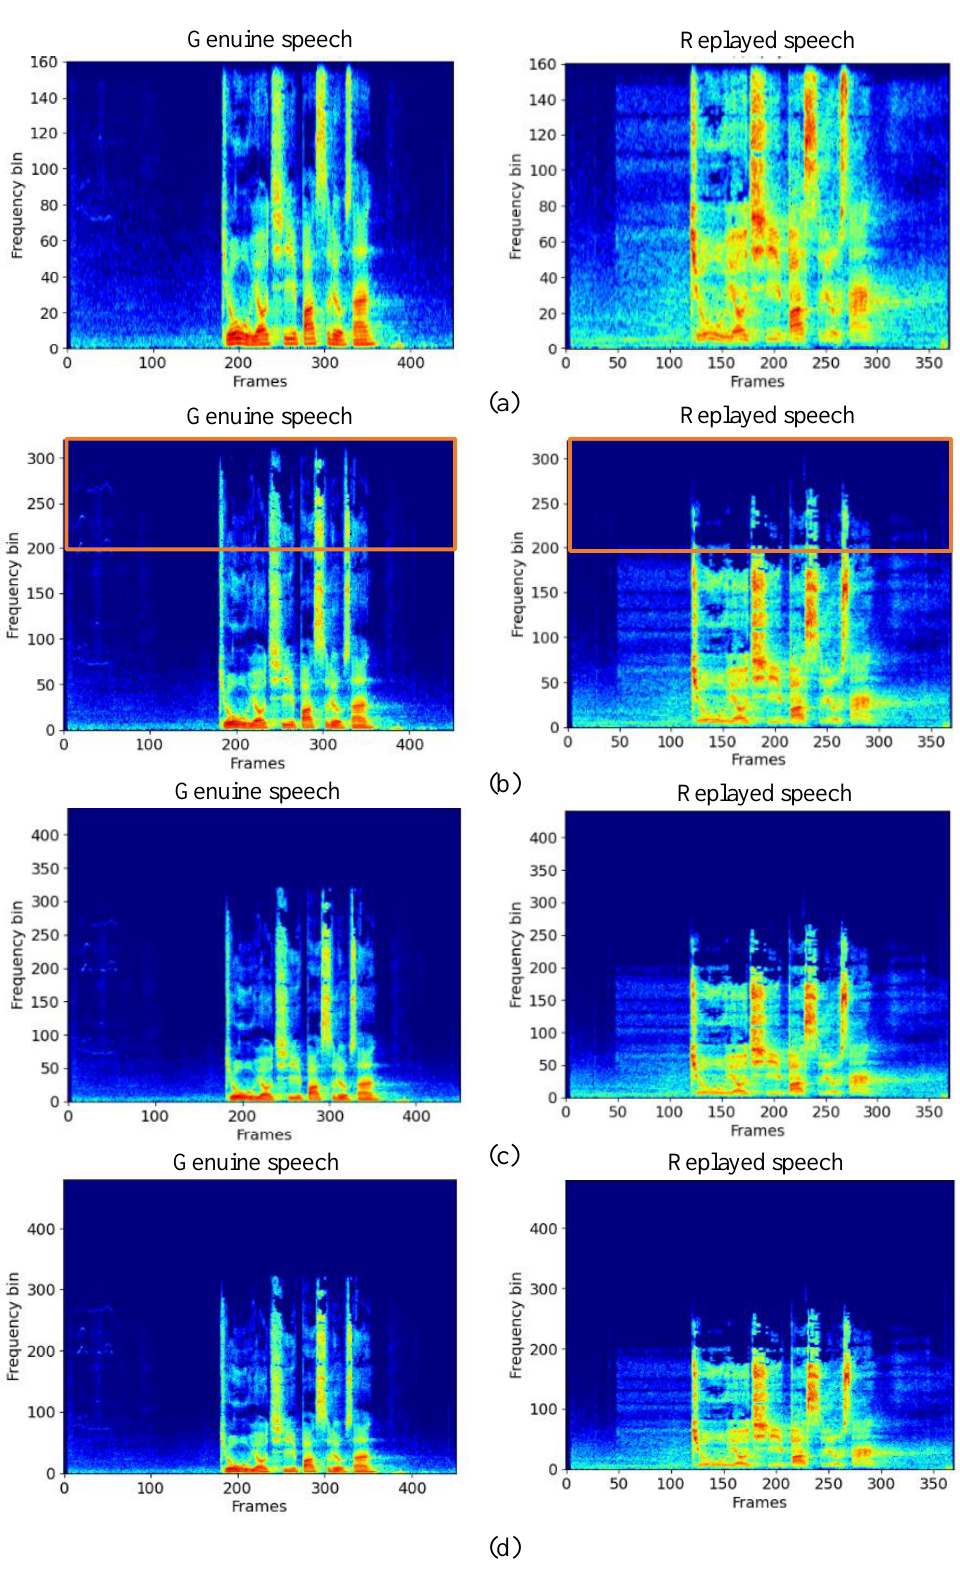
Figure 3. The spectral difference between genuine speech and replayed speech at the sampling rate between 16 kHz—48 kHz. ( a – d ) are the spectrum at different sampling rates of 16 kHz, 32 kHz, 44.1 kHz, and 48 kHz, respectively.